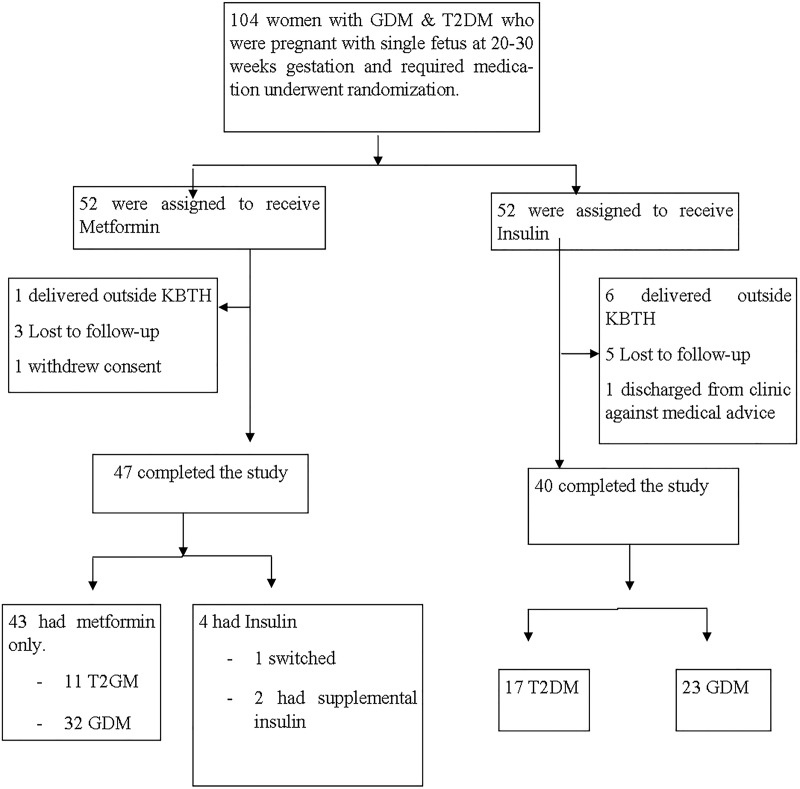
Flow diagram of participants from enrolment to term.